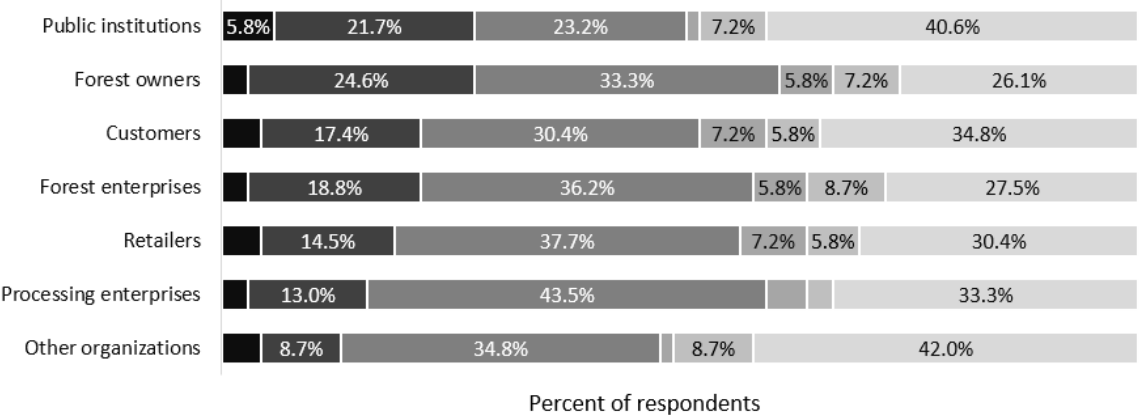
Figure 12. Respondents’ perceptions of the effectiveness of their promotional activities with reference to the subjects to whom these were addressed; N = 69. Table 5. Respondents’ perception s of the effectiveness of their promotional activities with refer-